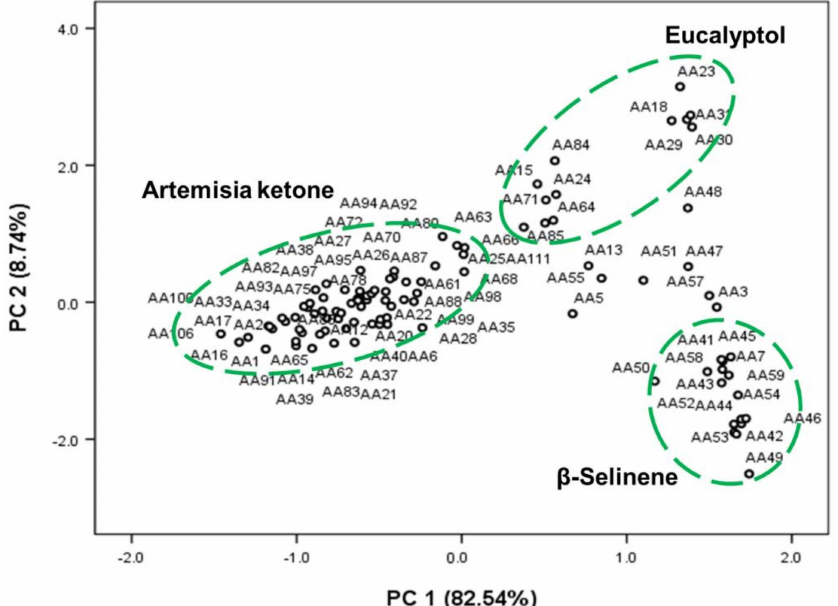
Figure 5. The scatter plot of PCA shows A. annua individuals’ relativeness based on 35 common chemicals: green circles indicate three major groups of the A. annua individuals: artemisia ketone, eucalyptol, and β -selinene